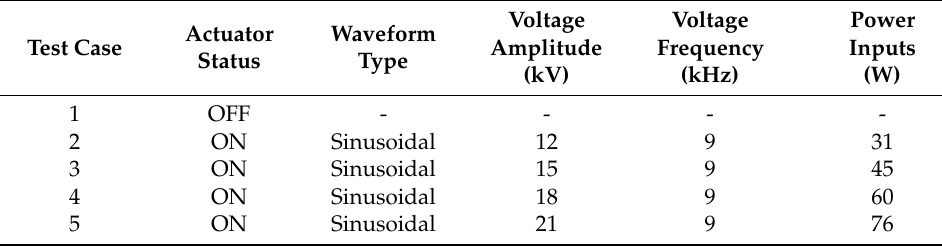
A mass flowmeter was utilized to regulate and measure the flow